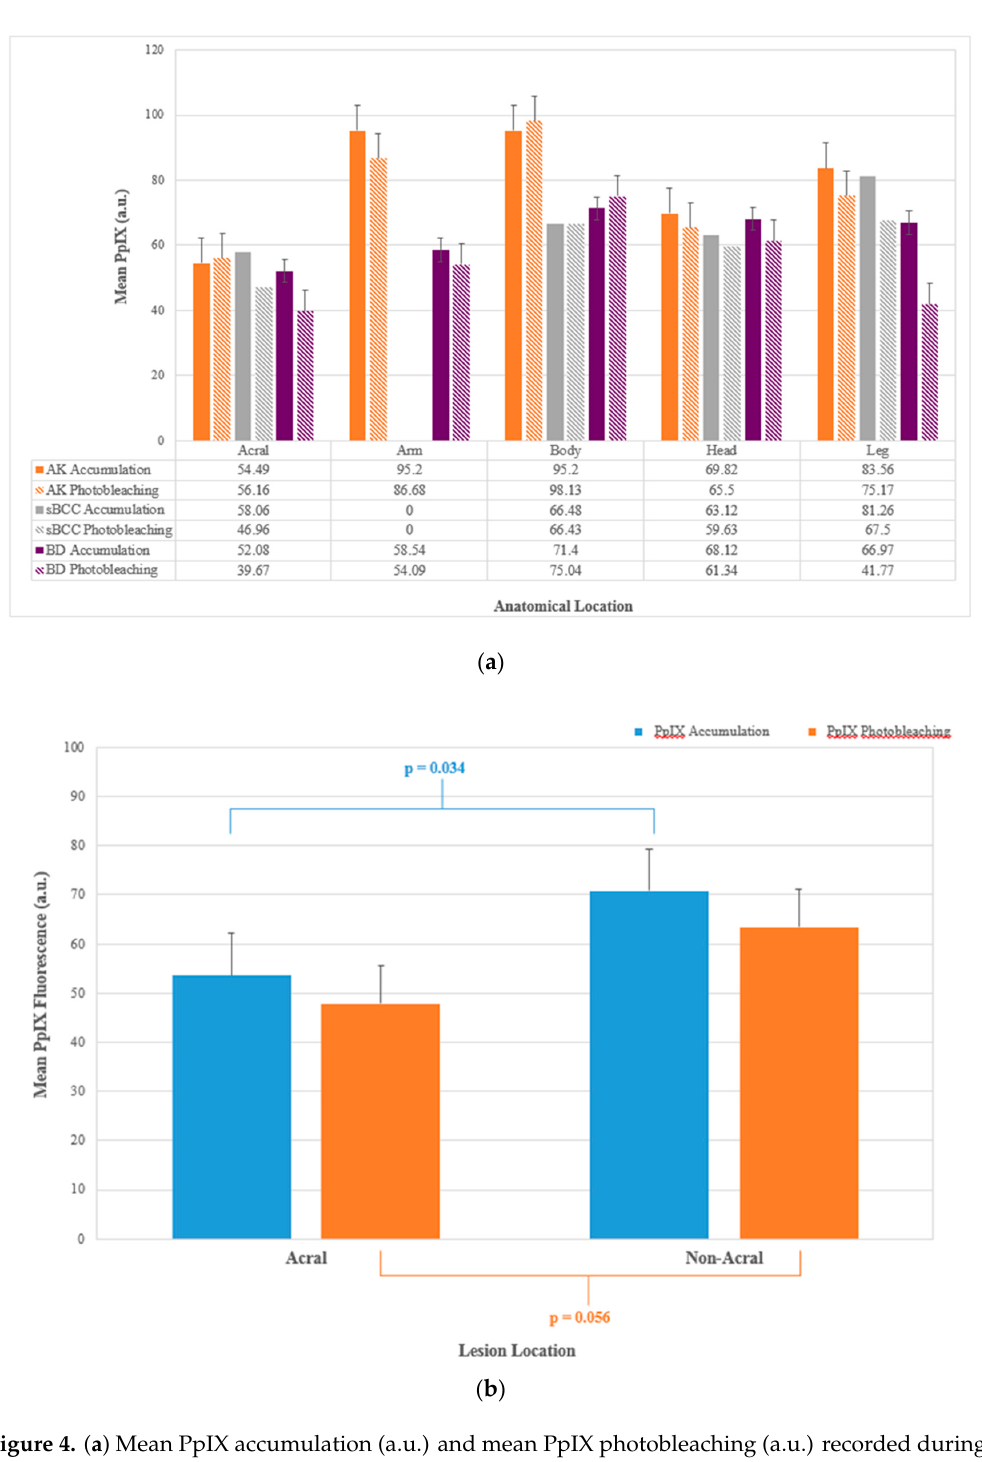
Figure 4. ( a ) Mean PpIX accumulation (a.u.) and mean PpIX photobleaching (a.u.) recorded during MAL-PDT conducted in different licensed indications (AK, sBCC and BD) on different anatomical locations and ( b ) comparison of mean PpIX accumulation and mean PpIX photobleaching in acral versus non-acral lesions (AK, sBCC and BD) undergoing MAL-PDT. Bars on both panels represent the standard deviations of the data.